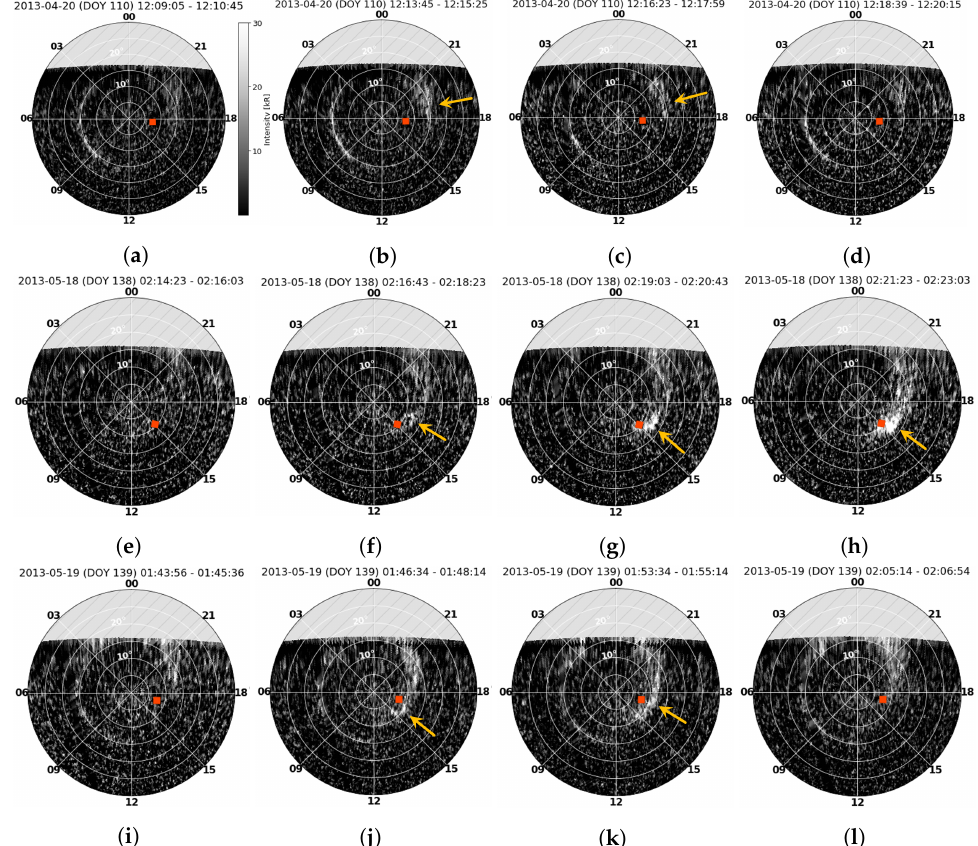
Figure 1. HST images of Saturn’s northern hemisphere in polar projection covering the evolution of 2013-110 (event no. 1) ( a – d ), 2013-138 (event no. 5) ( e – h ) and 2013-139 (event no. 6) ( i – l ). 0–30 ◦ colatitude range was extracted hence the innermost ring in every plot stands for 5 ◦ colatitude (or 85 ◦ latitude) and each step in between is 5 ◦ . The longitude is represented in local hour starting from 0 at the top anti-clockwise, hence dawn is at 6 LT, noon at 12 LT and dusk at 18 LT. All panels share the same colour bar as ( a ) represnting the auroral intensity in kiloRayleigh (kR). The integration time of the 2013 images is 100 s. The yellow arrows highlight the identified transient flash, while the red footprints represent Cassini’s average position simultaneous with every subexposure